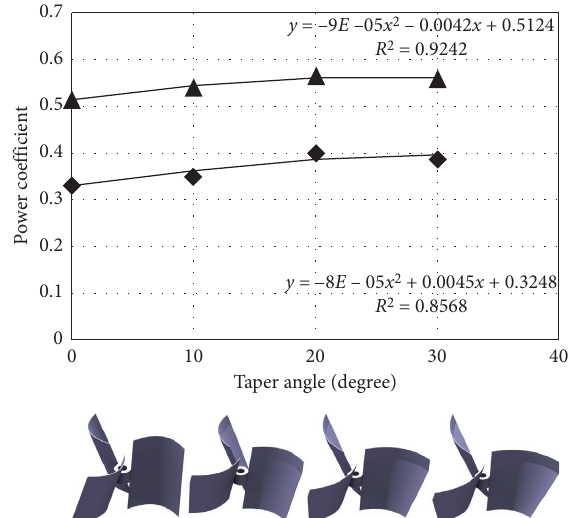
Figure 14: Set 4 data points (left to right—runners R9, R11, R12, and